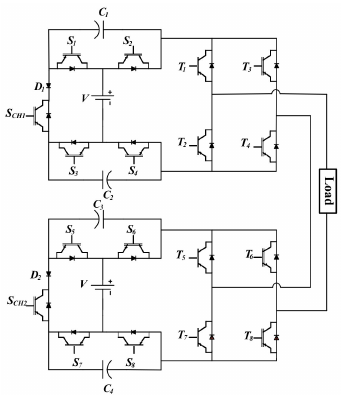
Figure 3. Circuit diagram of proposed extension for 13 level